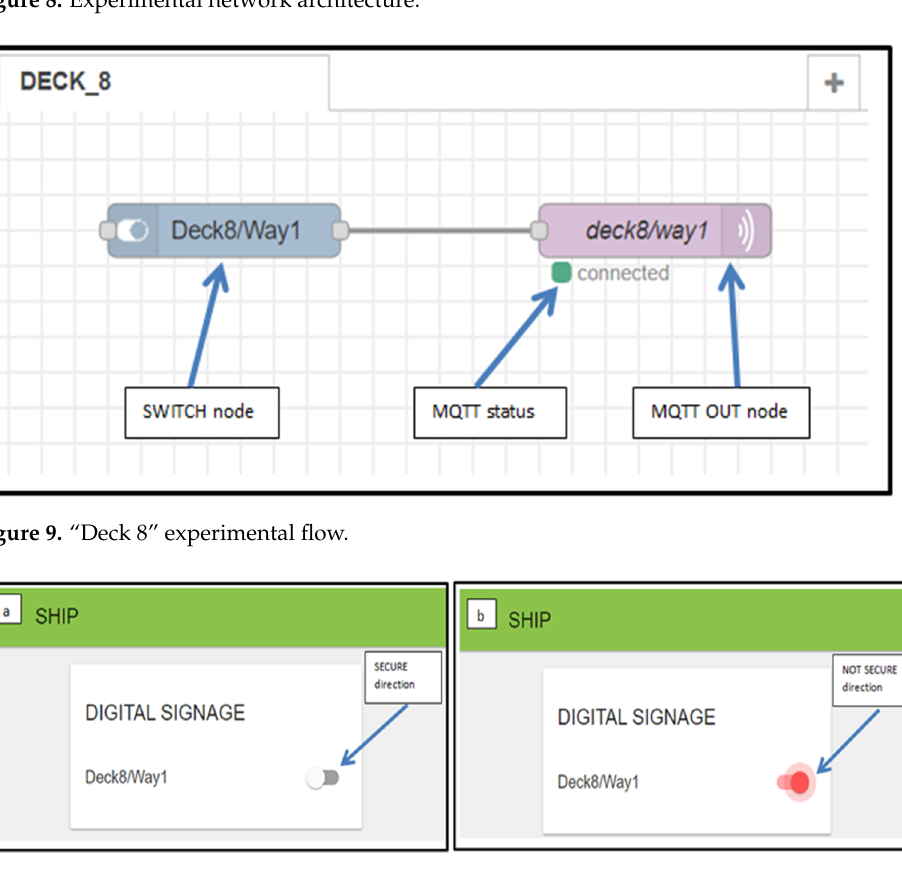
Figure 10. Experimental dashboard for controlling digital signage ( a ) SECURE; ( b ) NOT SECURE.